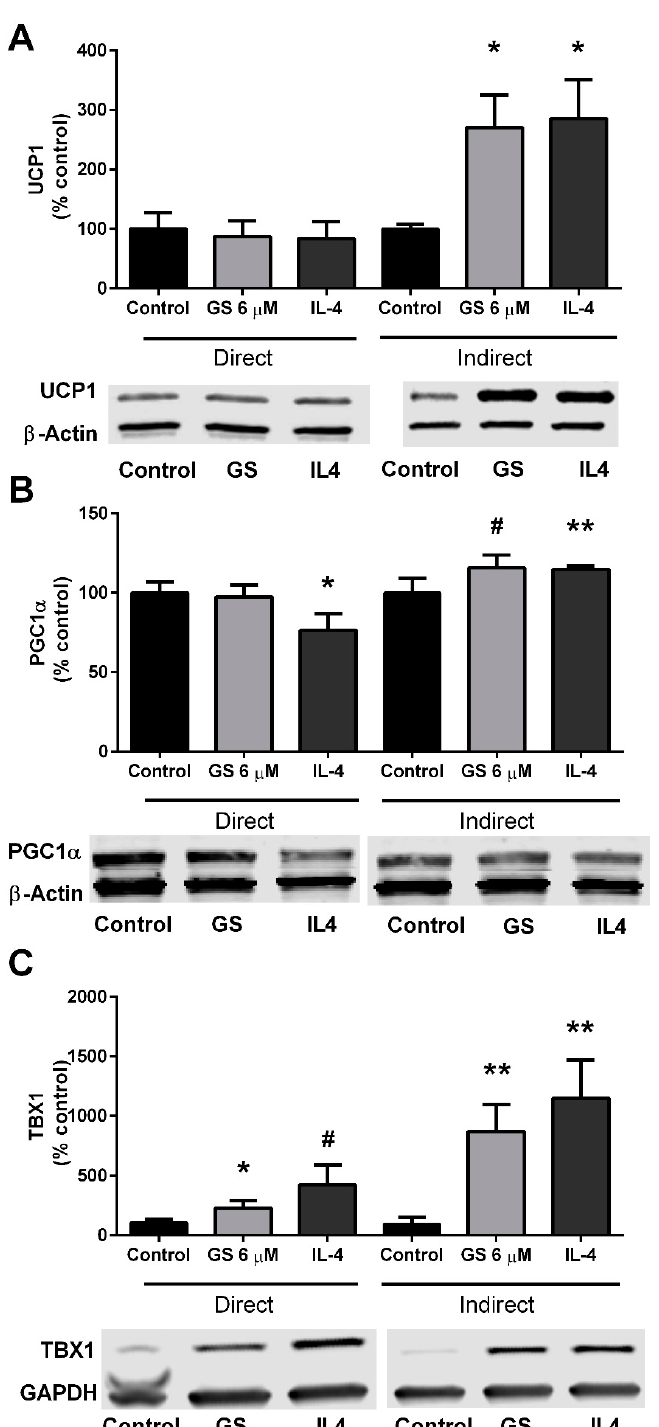
Figure 6. Conditioned media from GS-treated macrophages induces UCP1 upregulation in adipocyte. GS and IL-4 treatment upregulate UCP1 ( A ), PGC1 α ( B ), and TBX1 ( C ) expression through direct stimulations in 3T3-L1 adipocytes and indirectly via conditioned media from RAW264.7-treated macrophages. Data presented as mean ± SEM from n = 3–4 replicates per group. # p < 0.10, * p < 0.05, ** p < 0.01 vs. control. Abbreviations: Uncoupling protein 1 (UCP1), interleukin 4 (IL-4), peroxisome proliferator-activated receptor gamma coactivator 1-alpha (PGC1 α ), T-box protein 1